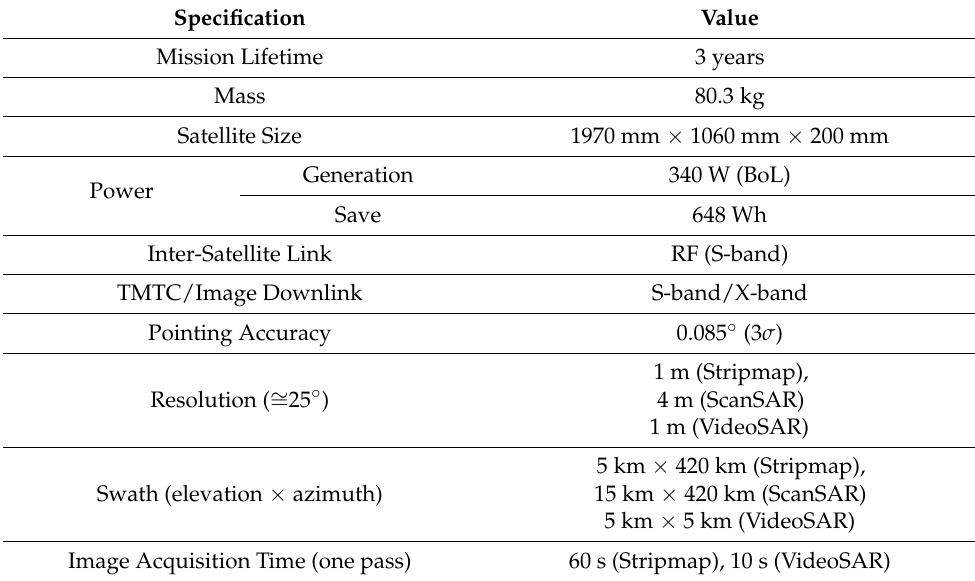
Figure 1. Mission operation concept of the S-STEP system. Table 1. S-STEP system specification.